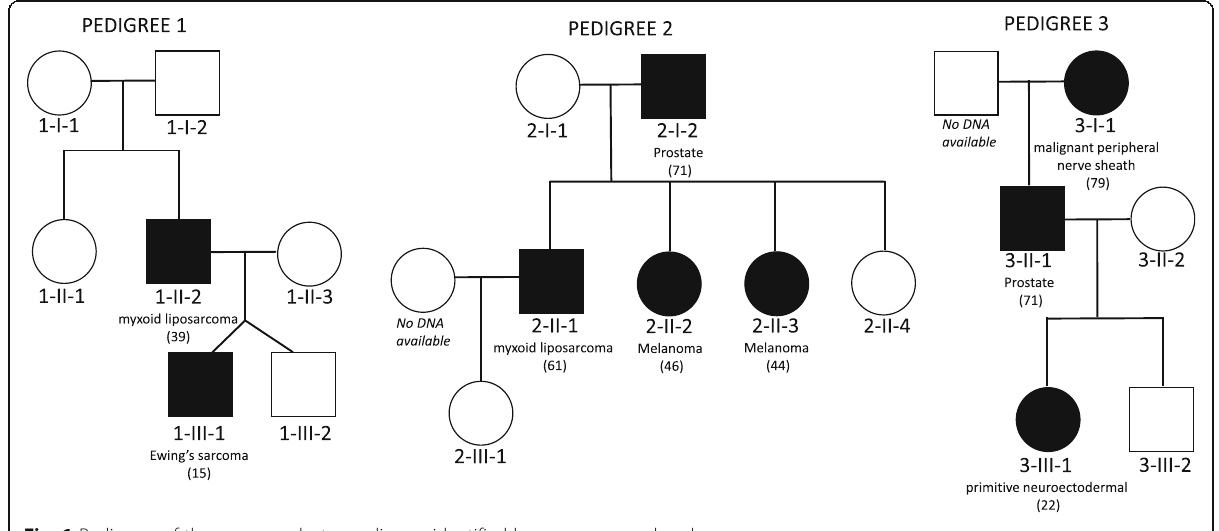
Fig. 1 Pedigrees of three cancer cluster pedigrees identified by a sarcoma